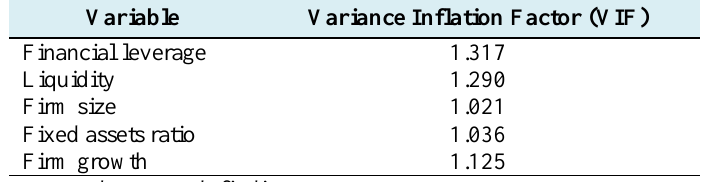
Table 10. The results of testing the absence of multicollinearity among explanatory variables in model (1) in the BSE